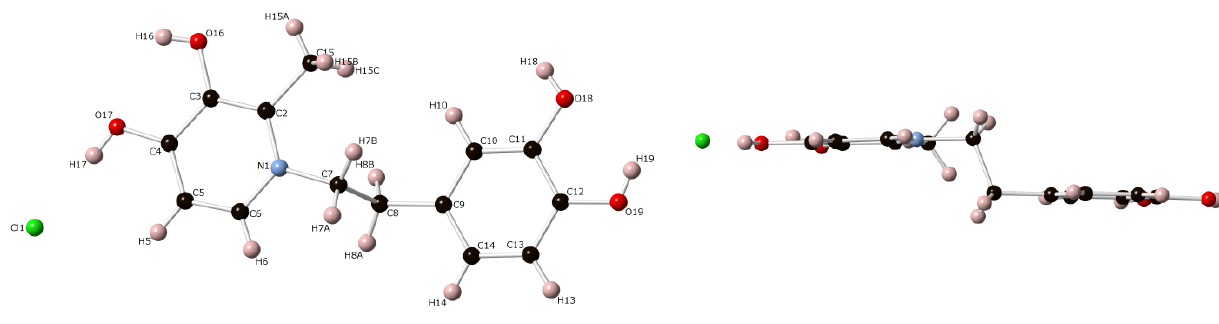
Figure 2. Two views of the molecular structure of the title complex with a molecule of methanol omitted for